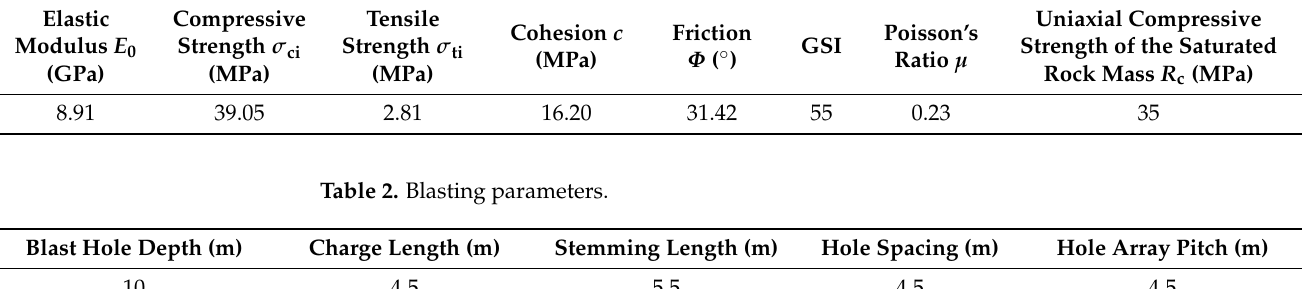
Table 1. Mechanical properties of the rock mass.